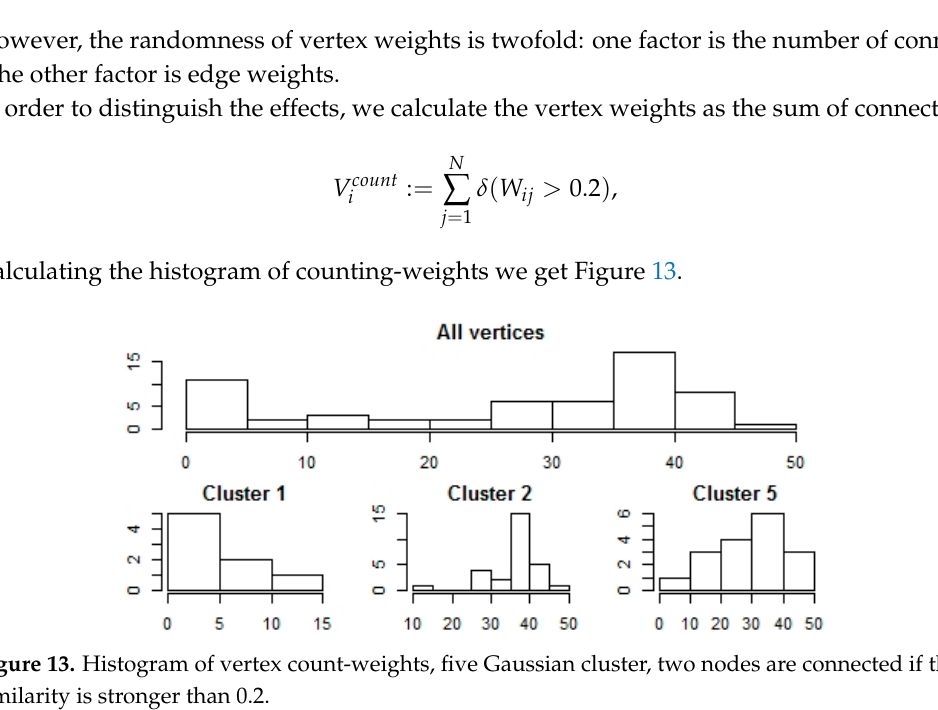
Figure 12. Histogram of vertex weights, five Gaussian cluster, two nodes are connected if their Gaussian similarity is stronger than 0.2.